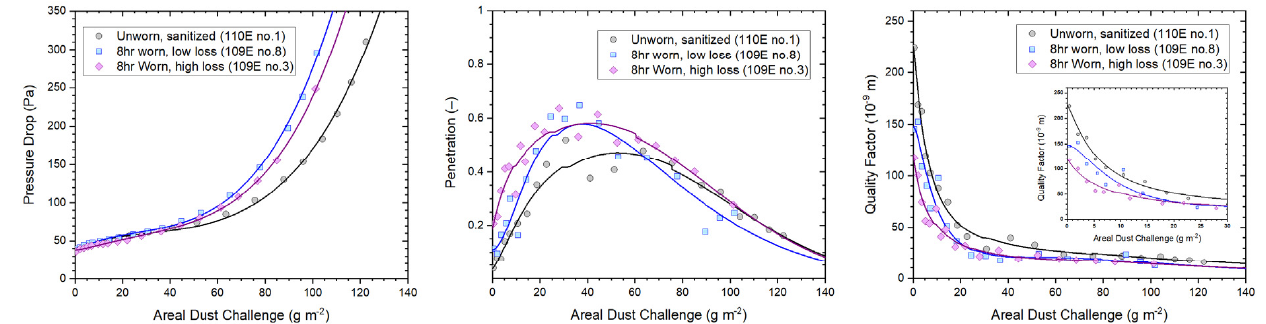
Figure 7. Pressure drop of samples before and after wearing by participants.